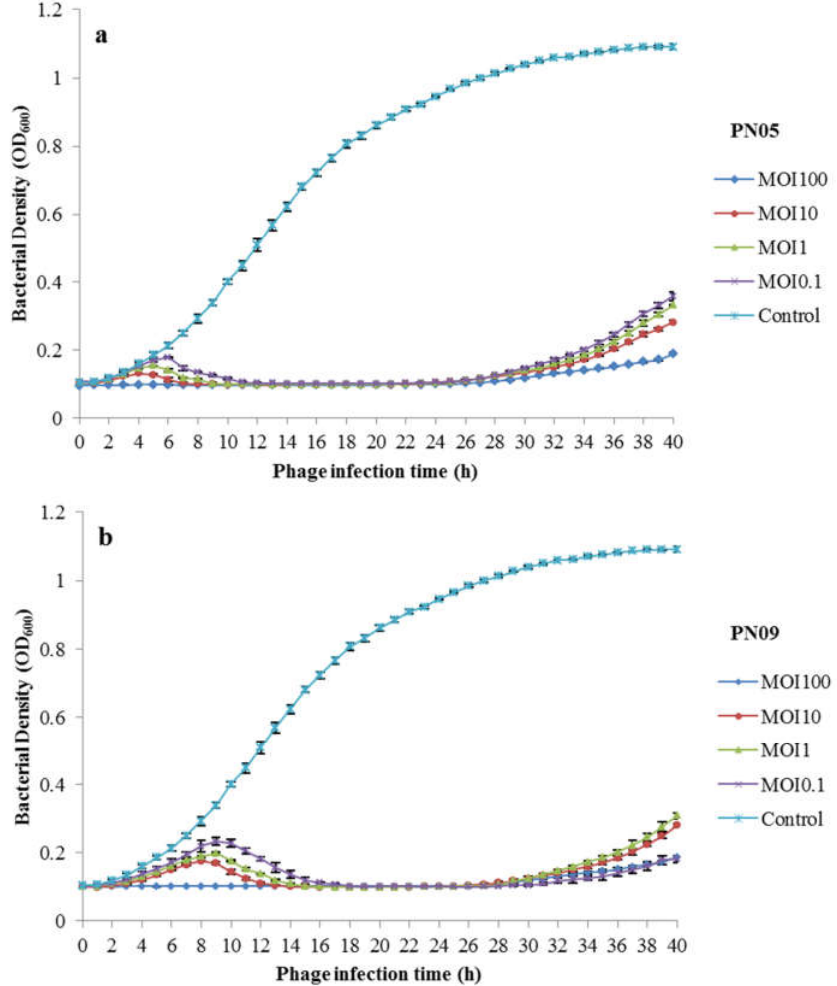
Figure 2. Bacteriolytic activity of the phages against Psa (SCJY02-1) in vitro. Early exponential cultures of Psa were treated with ( a ) PN05 or ( b ) PN09 at MOIs of 0.1, 1, 10 and 100, respectively. Psa culture inoculated with SM buffer instead of phage diluent was used as a negative control. Data are the mean ± standard deviation of three independent assays.